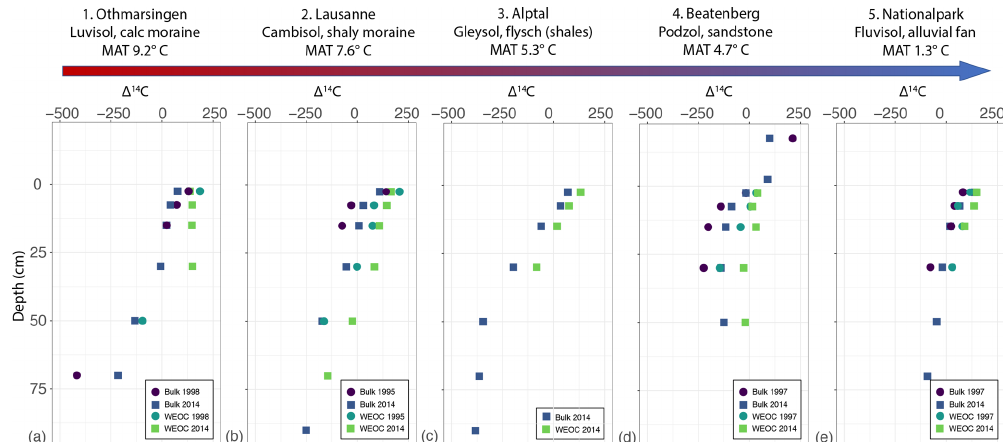
Figure 4. (a–e) Changes in radiocarbon signature of both bulk soil and WEOC over 2 decades at four sites on a climatic gradient. For Alptal (Gleysol) (c) only the 2014 time point was available. For the warmer locations Othmarsingen and Lausanne (Luvisol, Cambisol MAT 9.2– 7.6 ◦ C), depletion in bomb-derived radiocarbon occurs in the first 5cm of soil in 2014 as compared to 1995–1998. The colder Beatenberg site (Podzol, MAT 4.7 ◦ C) is marked by a clear enrichment of 14 C in the mineral soil in 2014 w.r.t. 1997. At the coldest site Nationalpark (Fluvisol, MAT 1.3 ◦ C) almost all samples, taken 2 decades after the initial sampling, show an enrichment in radiocarbon signature. WEOC contains bomb-derived carbon in the topsoil in 2014 at all sites. Table 2. Vegetation and soil data of the study sites. Soil water potentials (hPa) are for 15cm depth. Location a Deciduous tree Dominant tree Inferred lag carbon Organic layer Soil water potential species (%) b species b fixation (yr) Type a (hPa) percentiles b 5th 50th 95th Othmarsingen 100 Fagus sylvatica 2 Mull − 577 − 39 − 9 Lausanne 80 Fagus sylvatica 3 Mull − 547 Alptal c 15 Picea abies Mor to anmoor Beatenberg 0 Picea abies Nationalpark 0 Pinus